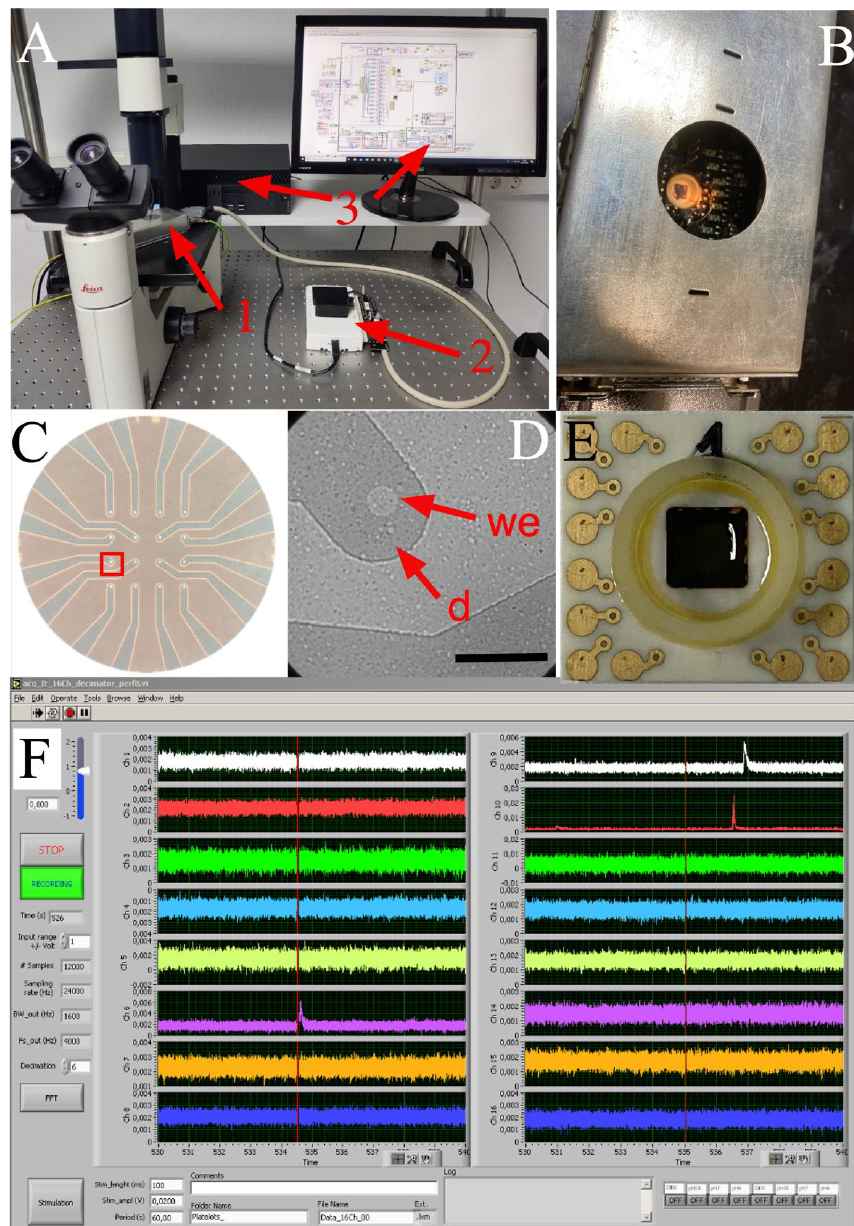
Figure 2. Diamond-based MEA device for amperometric recording of platelet exocytosis. ( A ), General view of the recording system. 1 , When using transparent BDD-on-quartz MEAs, the front-end unit can be placed on the stage of an inverted microscope to examine platelet distribution. 2 , The USB multi I/O unit and the analog low-pass filter plug-in board. 3 , The acquisition program written in LabView ® and a PC complete the system. ( B ), Faraday cage containing the MEA chip and amplifiers. ( C ), A BDD-on-quartz MEA showing the 16-electrode layout. ( D ), Magnified view of the red inset in C. Isolated human platelets on a single electrode observed by DIC microscopy: we , the open BDD spot acting as a working electrode; d , the passivated BDD structure acting as a planar electrical connection. Calibration bar = 50 µ m. ( E ), BDD-on-silica MEA showing the gold contact pads. These opaque MEAs have the same 16-electrode layout as in panel C. ( F ), a 10 s recording from the 16 auto-scalable traces show three amperometric spikes in channels 6, 9, and 10. Table 1. Kinetic parameters of amperometric spikes obtained with diamond MEAs. Data from 10 human subjects. Calculations were performed on the N basis (average was found by taking all spikes from each subject and the results were used for statistics). We used the same spikes shown in Fig. 3C.; Means ± SEM. ***P < 0.005: n.s: not significant. Student ’s t test. MEA Imax (pA) Q (pC) t 1/2 (ms) m (nA/s) Basal 5.65 ± 0.40